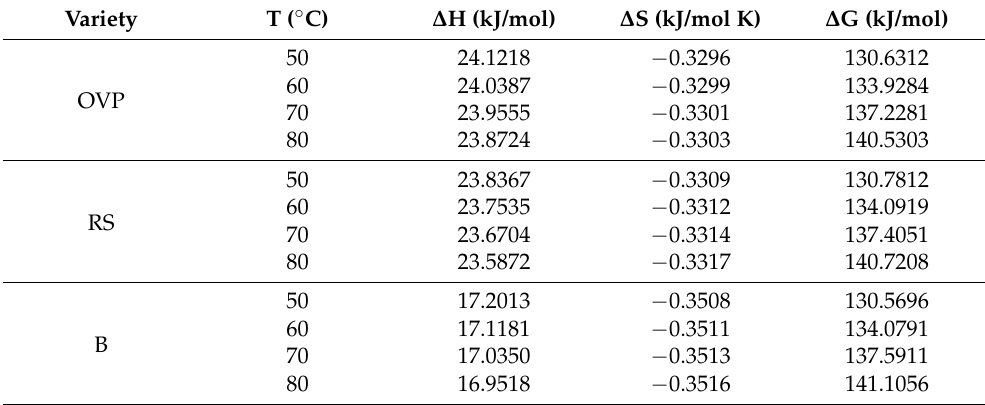
Table 6. Thermodynamic properties of germinated faba beans dried at temperatures of 50, 60, 70 and 80 ◦ C.